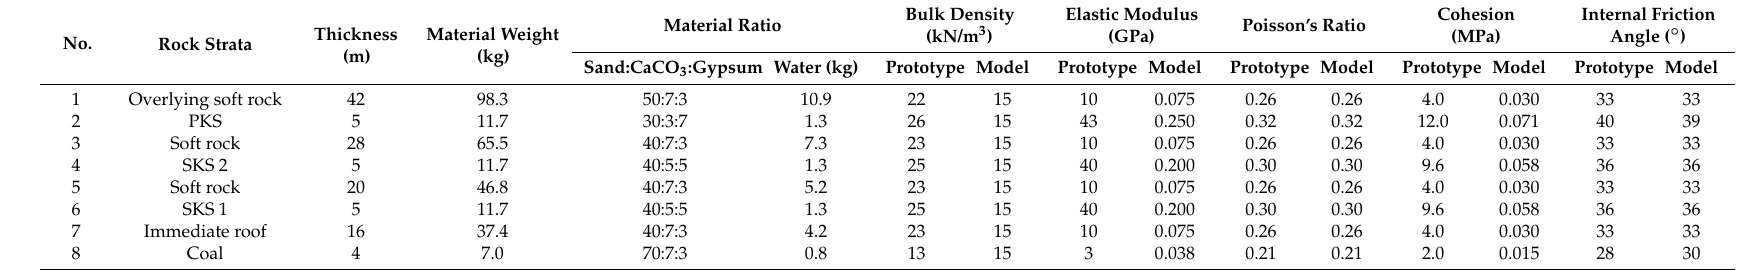
Table 2. Mixing ratio of similarity material and physico-mechanical parameters of each